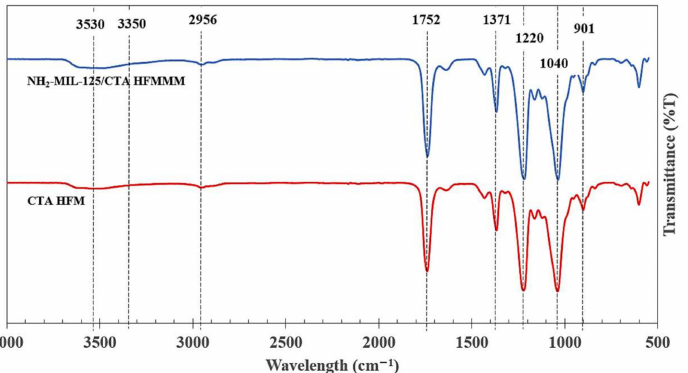
Figure 5. FTIR Spectra of CTA HFMs and NH 2- MIL-125(Ti)/CTA